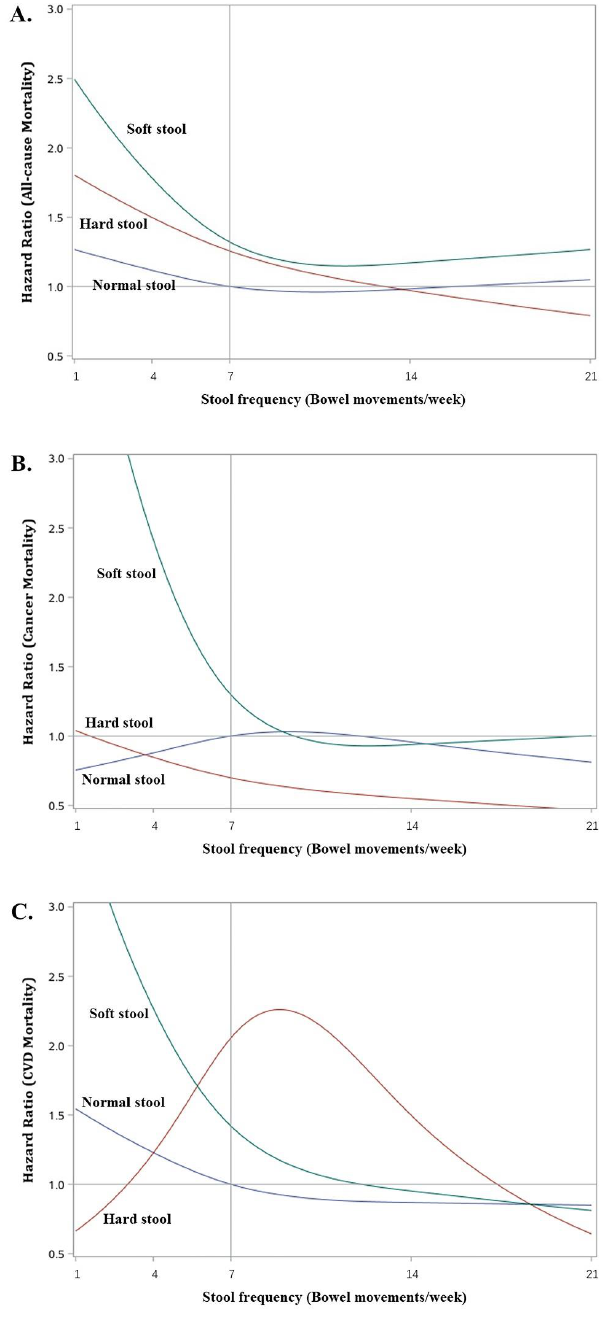
Figure 3. Non-linear relationship between stool frequency and all-cause mortality ( A ), cancer mortal- ity ( B ), and CVD mortality ( C ) stratified by stool type in U.S. adults (NHANES 2005–2010). The non- linear relationship is depicted by using a restricted cubic spline with 3 knots at stool frequencies of 4, 7, and 14 times/week. The solid curves represent HRs (with respect to normal stool at 7 times/week) estimated by using weighted Cox regression models adjusted for age, sex, race/ethnicity, family income, BMI, smoking status, alcohol consumptions, physical activities, dietary fiber intake, and history of chronic diseases. Normal stool includes type 3 (a sausage shape with cracks in the surface) and type 4 (like a sausage or snake, smooth and soft) stools; Hard stool include type 1 (separate hard lumps, like nuts) and type 2 (like a sausage but lumpy) stools; Soft stool include type 5 (soft blobs with clear-cut edges), type 6 (fluffy pieces with ragged edges, a mushy stool) and type 7 (watery, no solid pieces)